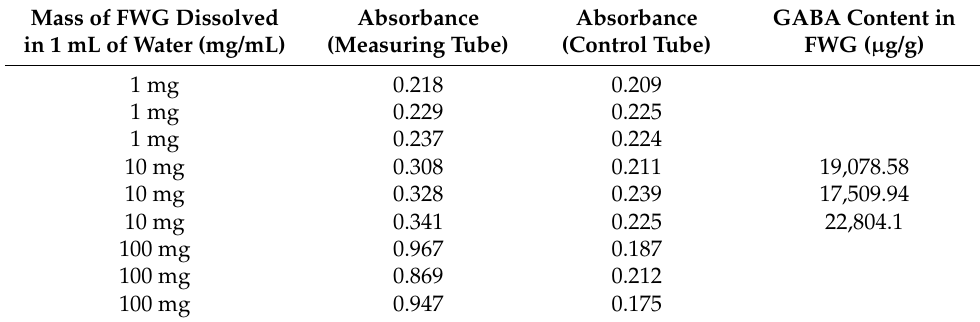
Table 1. GABA content in